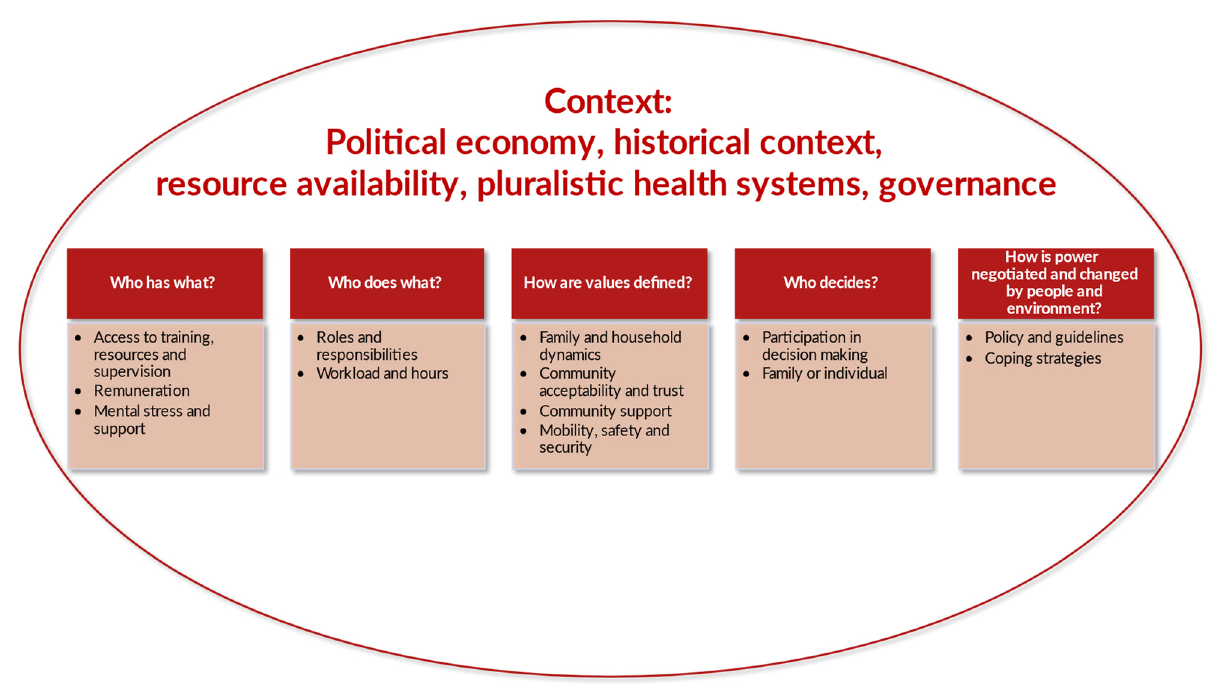
Figure 1. Gender analysis framework (adapted from Morgan et al. 2016).